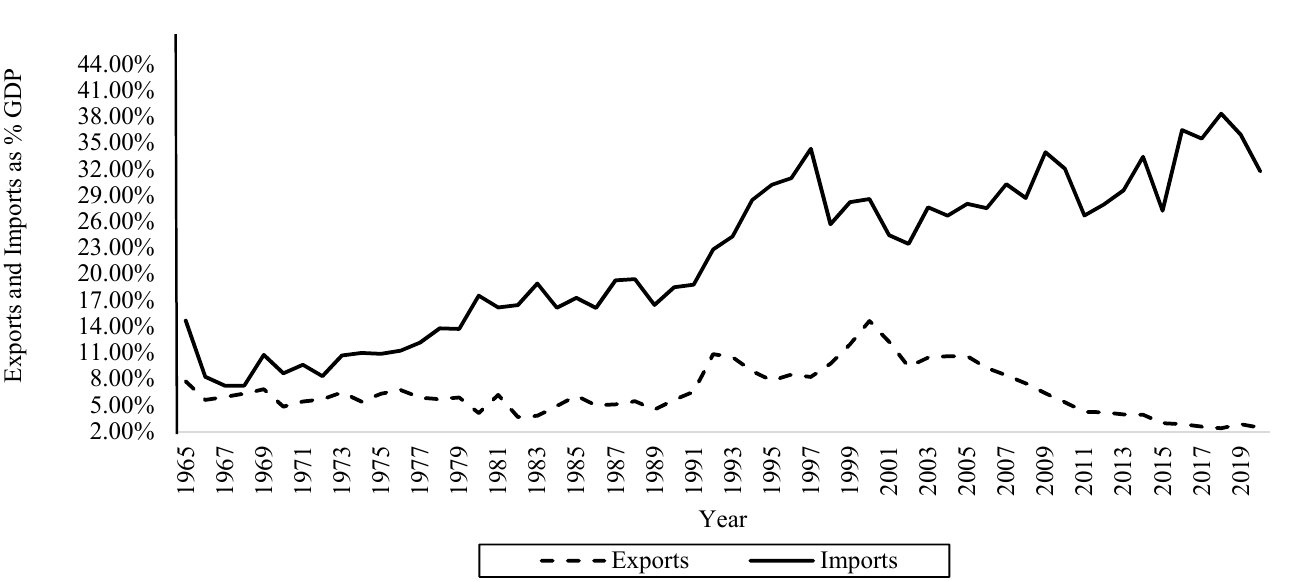
Figure 2. Percentage of exports and imports to GDP. This figure presents Nepal’s exports and imports as a percentage of GDP from 1965 to 2020. The solid and dashed lines represent exports and imports, respectively. This graph is generated using data available through the World Bank.